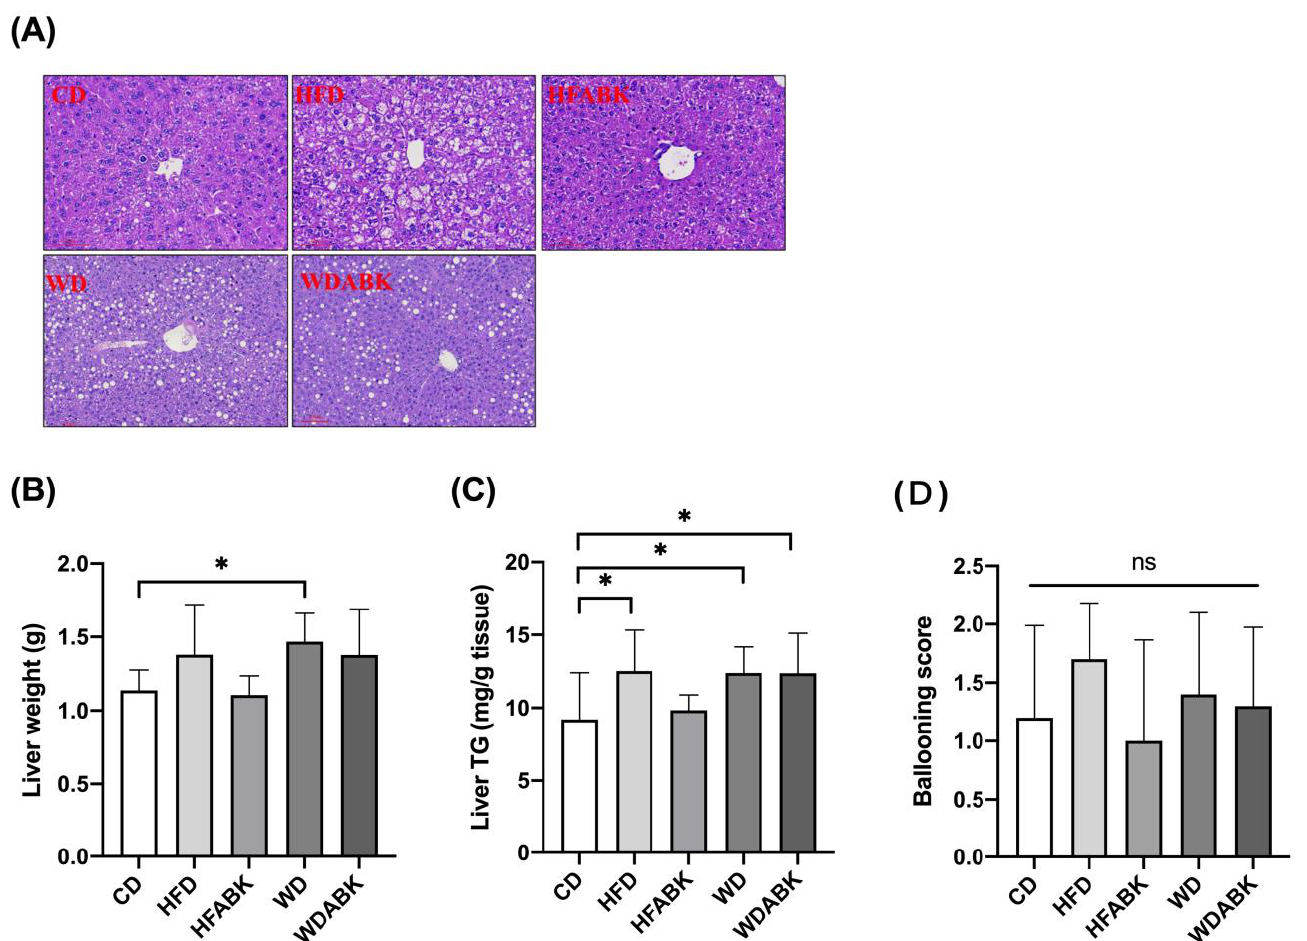
Figure 3. Effect of AB-Kefir on hepatic steatosis in HFD- and WD-fed mice. ( A ) H&E staining of representative histological sections of the liver tissue. Scale bar = 100 µm. ( B ) Liver weights and ( C ) hepatic triglyceride levels and ( D ) hepatocellular ballooning score are shown. Data are expressed as mean ± SD (n = 10 per group). * p < 0.05. ns: not significant. Statistics were analyzed by using one-way ANOVA with Tukey’s post hoc test.